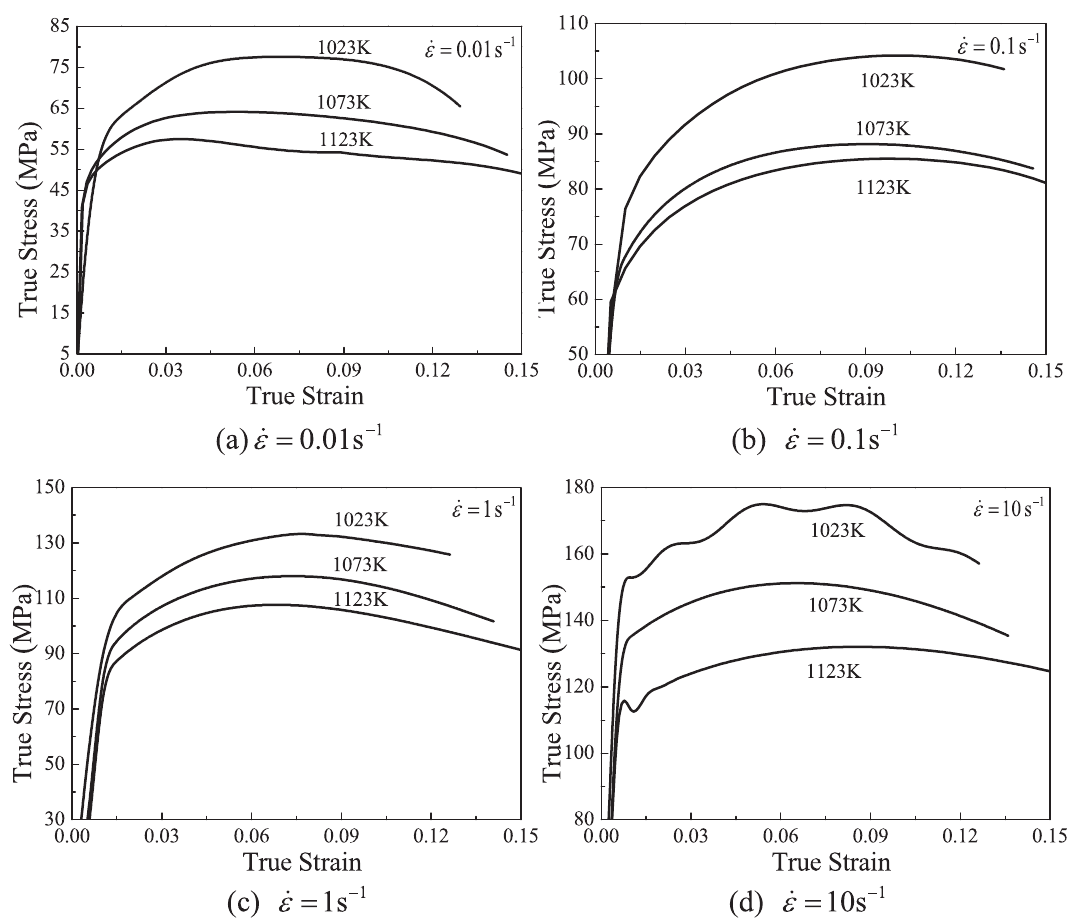
Fig. 3: True stress-strain curves of BR1500HS alloy obtained by Gleeble 3500 under the different deformation temperatures with strain rates: (a) 0.01 s − 1 ; (b) 0.1 s − 1 ; (c) 1 s − 1 ; (d) 10 s −